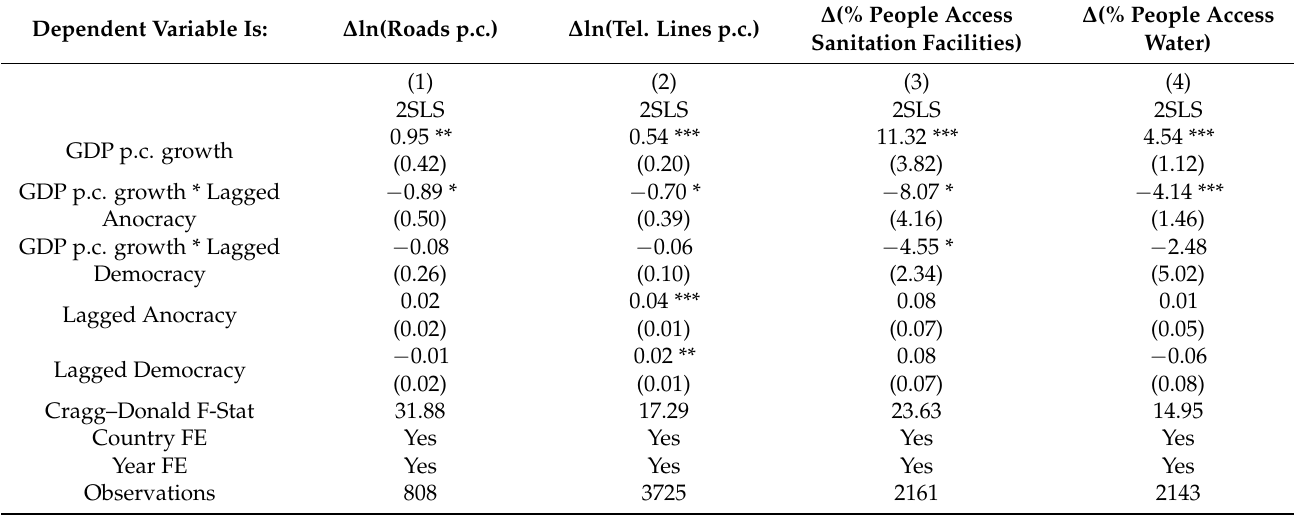
Table 10. GDP growth, anocracy, and infrastructure: (interaction model with anocracy and democracy). Dependent Variable Is: ∆ ln(Roads